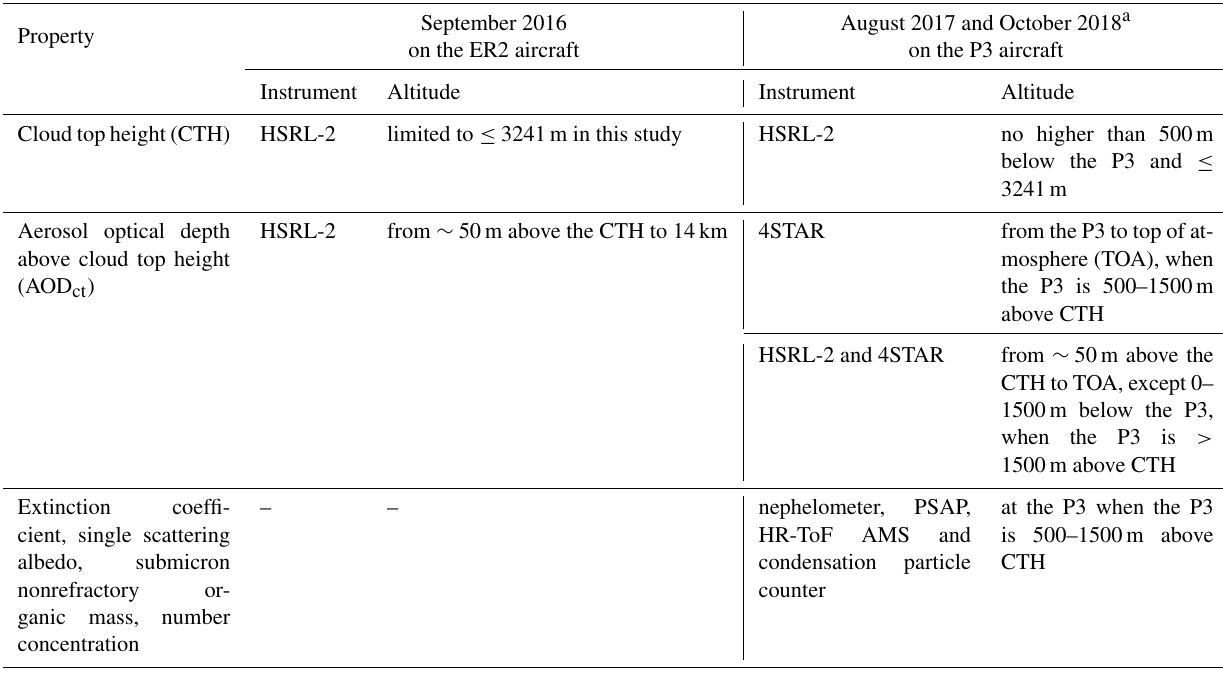
Table 1. Properties and instruments used in this study and the altitudes they refer to.